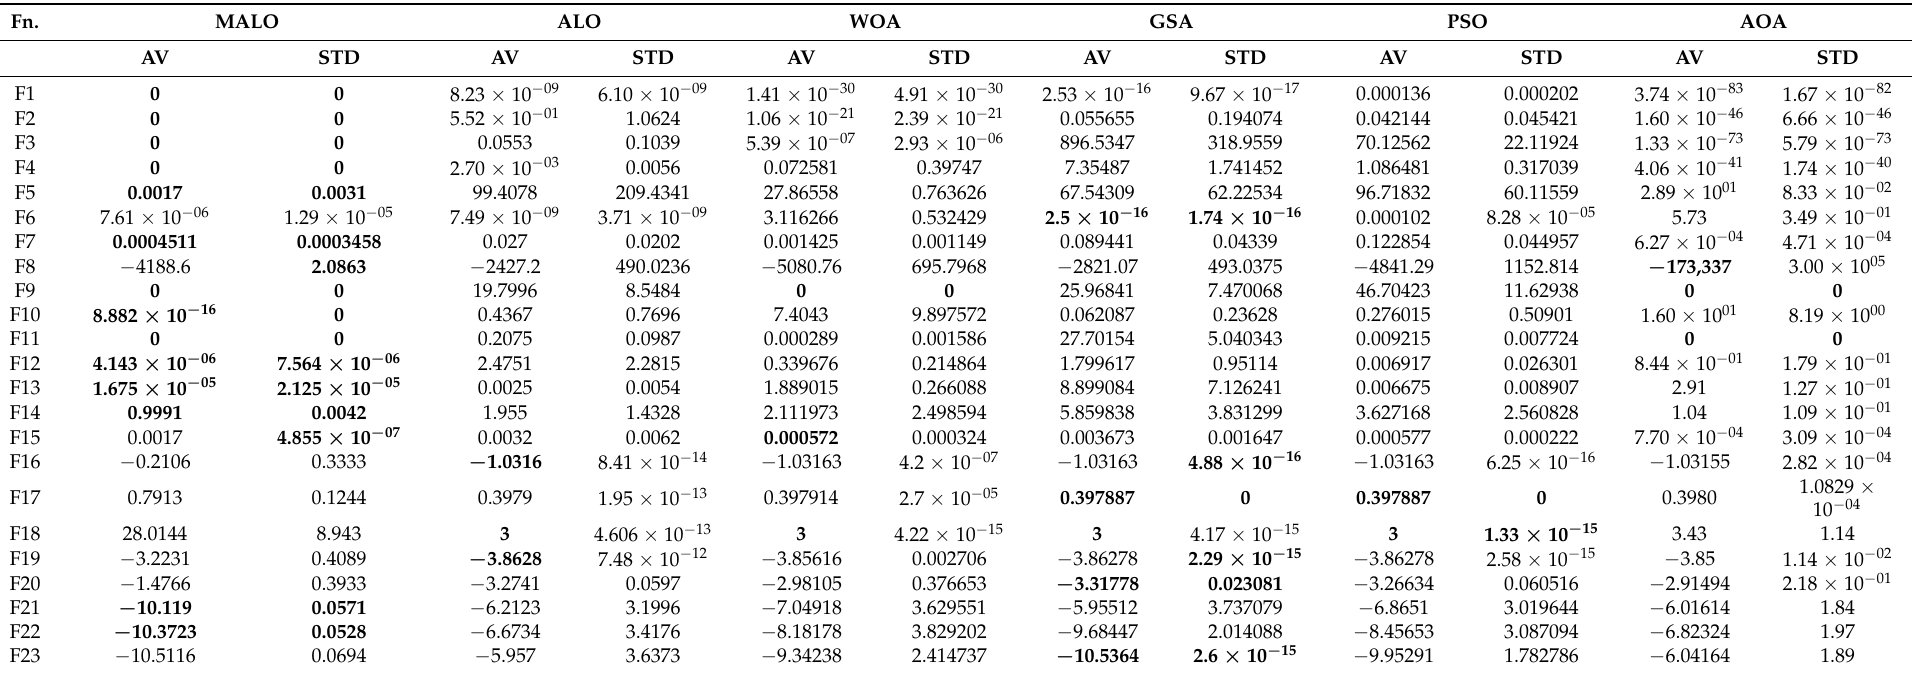
Table 4. Results of malo and other algorithms for benchmark functions (500